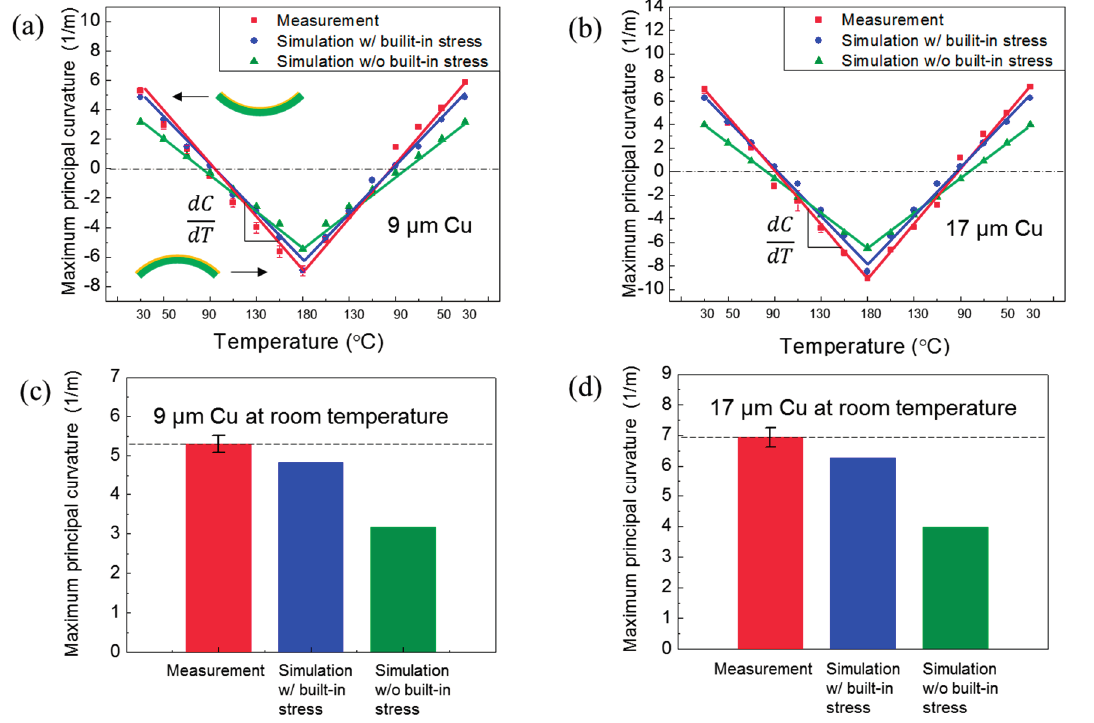
Figure 7. Maximum principal curvature comparison of type B FRP specimens among experimental measurement, simulation results with and without built-in stress: ( a ) type B specimens with 9 μ m Cu; ( b ) type B specimens with 17 μ m Cu; and maximum principal curvature at room temperature with ( c ) 9 μ m Cu and ( d ) 17 μ m Cu